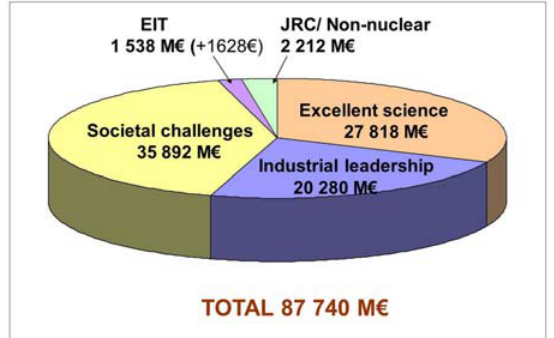
Figure 1. Horizon 2020 budget breakdown